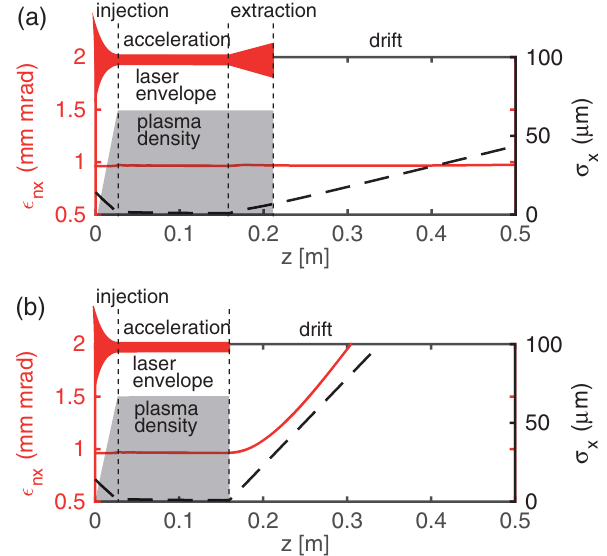
FIG. 2. Evolution of the electron beam size (black line) and emittance (red line) in the plasma booster stage. Adding an adiabatic extraction section (a), the beam emittance is effectively = Δ z ¼ 0 . 18 mm mrad = m, with a minimum beam constant, Δ ϵ nx divergence of only 130 μ rad. In (b), the beam is extracted through the sharp ending of the focusing force, with a beam divergence of 550 μ rad and an emittance growth of Δ ϵ = Δ z ¼ 12 mm mrad = m, nx over one order of magnitude larger compared to the adiabatic extraction (a). Here, the gray areas indicate the plasma density profile, and the red areas schematically show the laser envelope. The laser evolution after the plasma is not